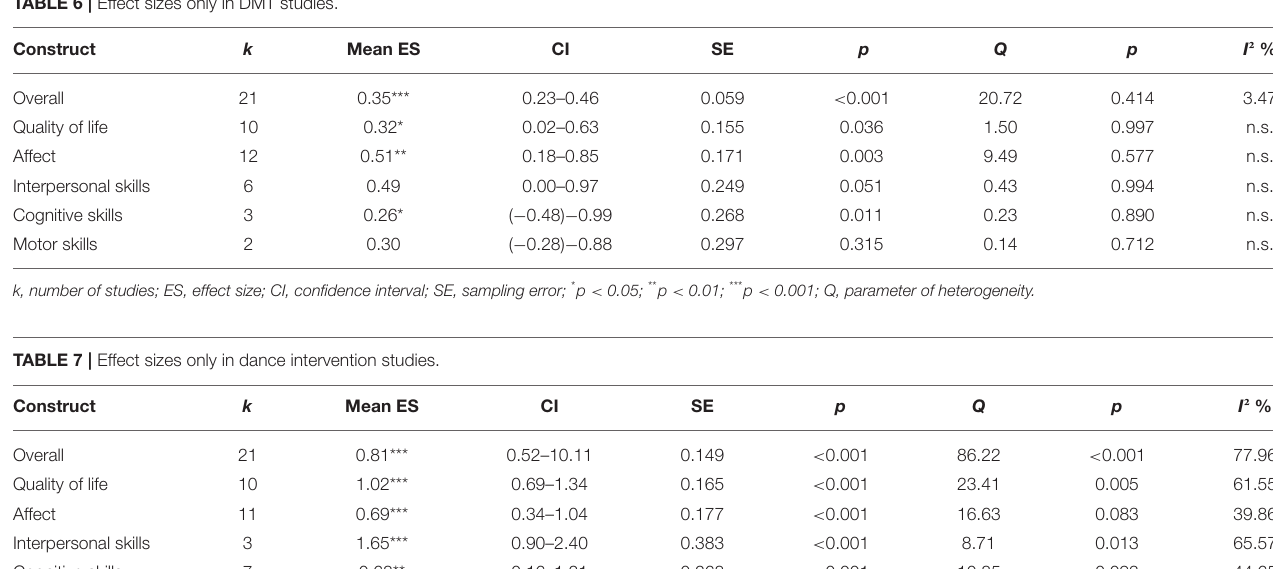
TABLE 6 | Effect sizes only in DMT studies.